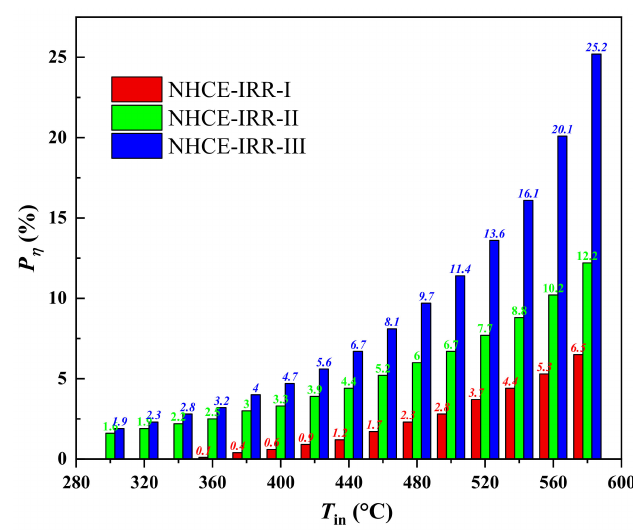
Figure 8. Percentage of energetic e ffi ciency enhancement of NHCEs versus inlet temperature.